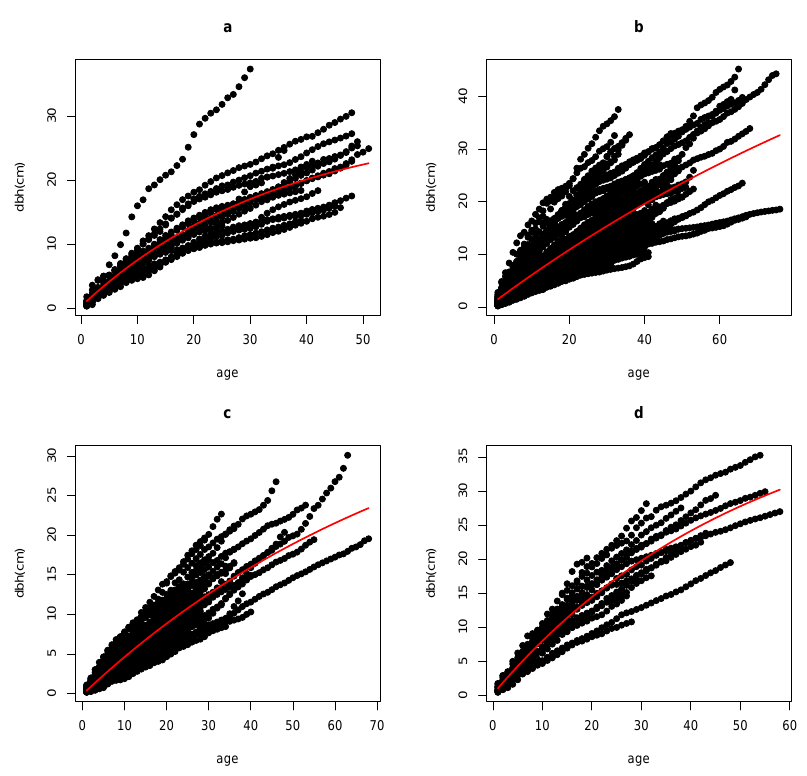
Figure 2. Chapman-Richards BAS model (2 parameters) model fits to the growth history of the species: dbh (cm) vs age (years) for ( a ) Pinus arizonica , ( b ) Pinus engelmannii , ( c ) Pinus strobiformis and ( d ) Pinus teocote .